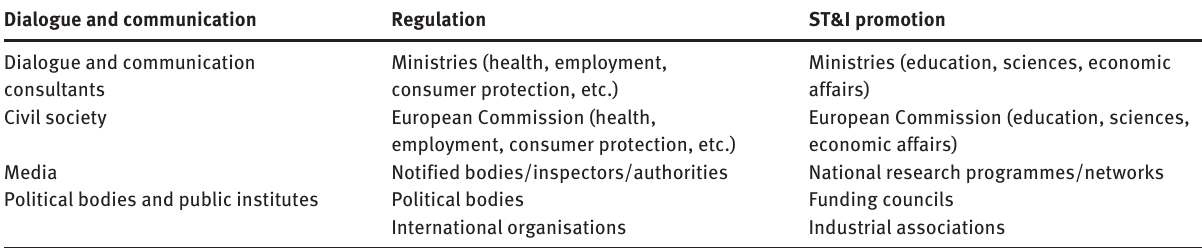
Table 1 Types of organisations